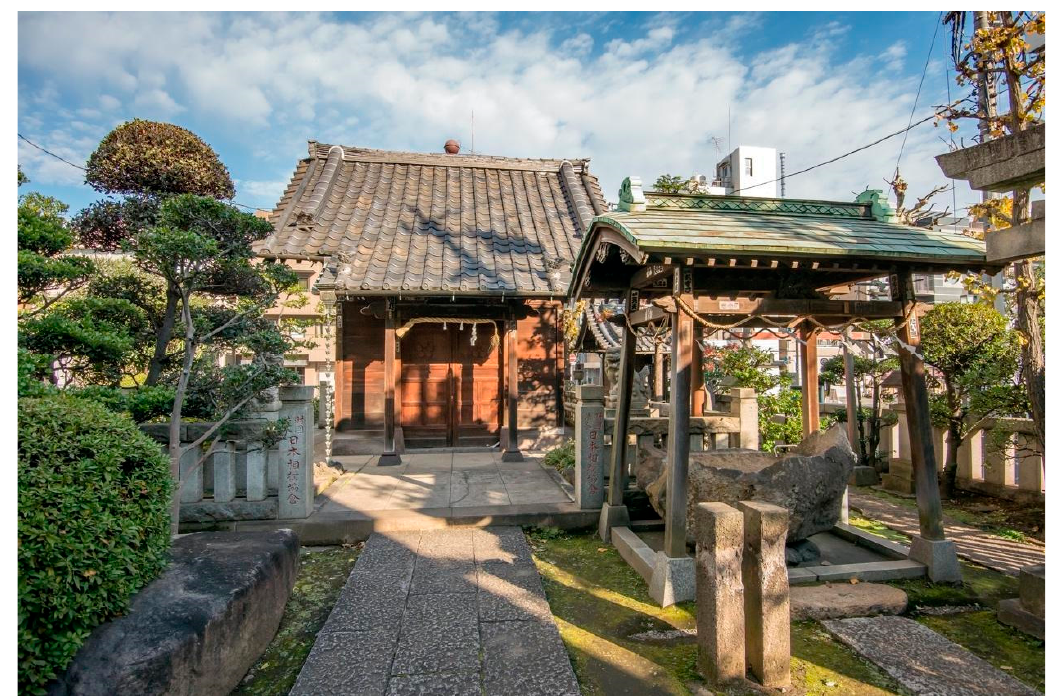
Figure 12. Nomi no Sukune Jinja, Tokyo. Reproduced with permission from Seimenjo; published by photolibrary.jp (image no. 5388785) (accessed on 28 August